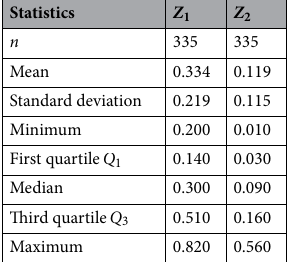
Table 1. Summary statistics of Z 1 and Z 2